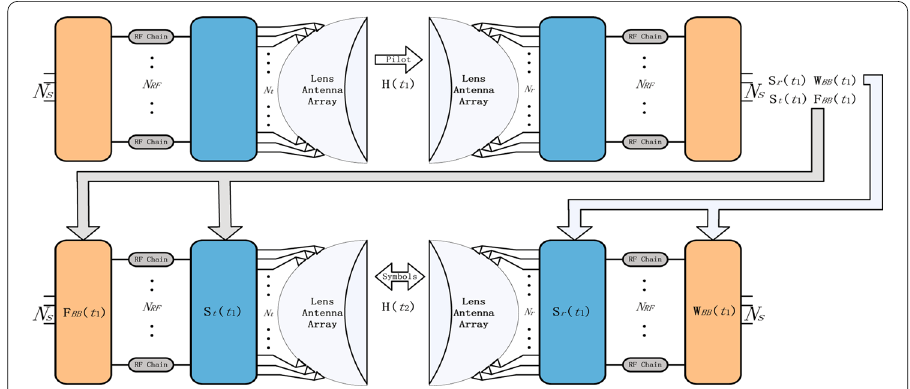
Fig. 4 Influence of time-varying mmWave massive MIMO